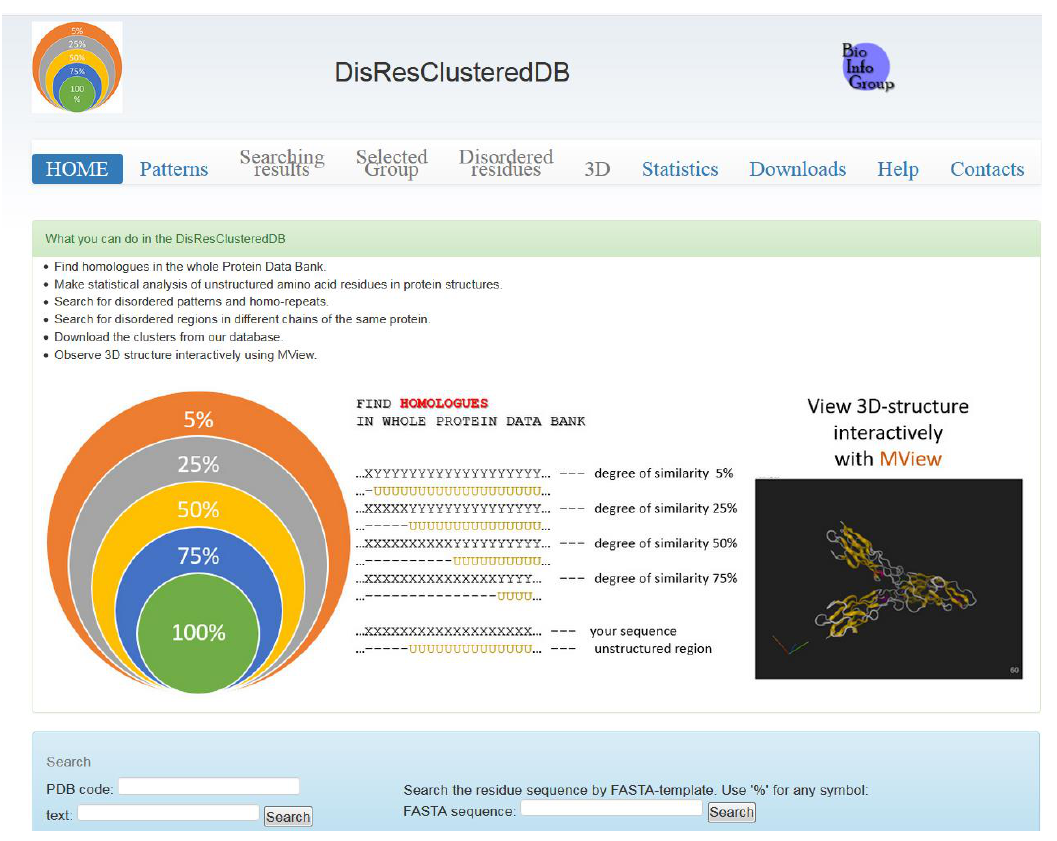
Figure 5. Common view of the database.